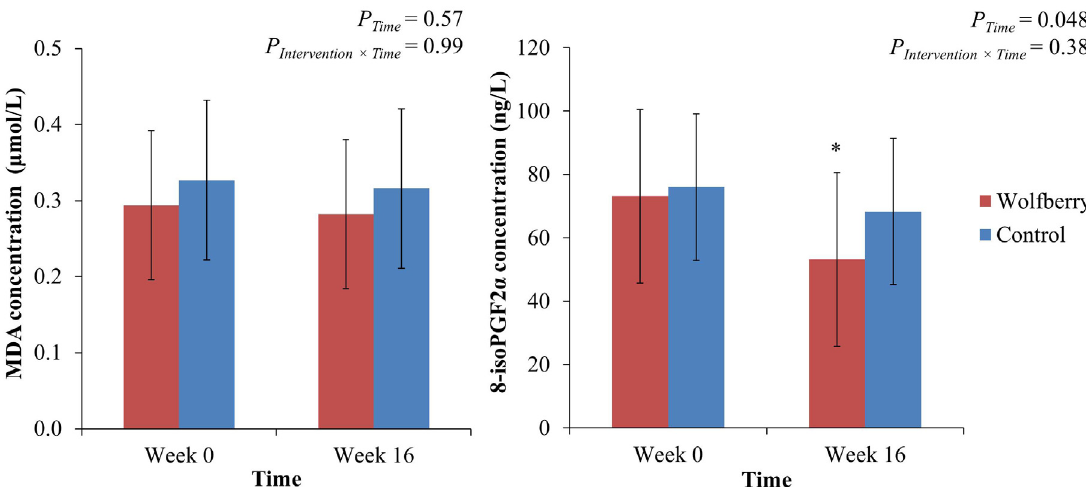
Figure 2. Concentrations of plasma oxidative stress biomarkers MDA and 8-isoPGF2 α for wolfberry group ( n = 22) and control group ( n = 18) of randomized controlled trial. Values are means with error bars representing the SD. Data analyzed with two-way mixed model ANOVA and post-hoc simple effects test by Bonferroni’s multiple contrasts. * p < 0.05 compared to the corresponding week 0 values. At week 0, there were no significant differences in plasma MDA ( p = 0.42) and 8-isoPGF2 α ( p = 0.82). Abbreviations: MDA, malondialdehyde; 8-isoPGF2 α , 8-iso-prostaglandin F2 α . Table 1. Changes in plasma carotenoids status at weeks 8 and 16 of randomized controlled trial 1